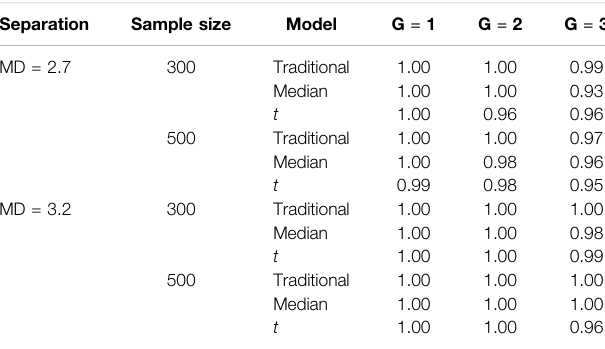
TABLE 1 | Proportion of converged datasets.